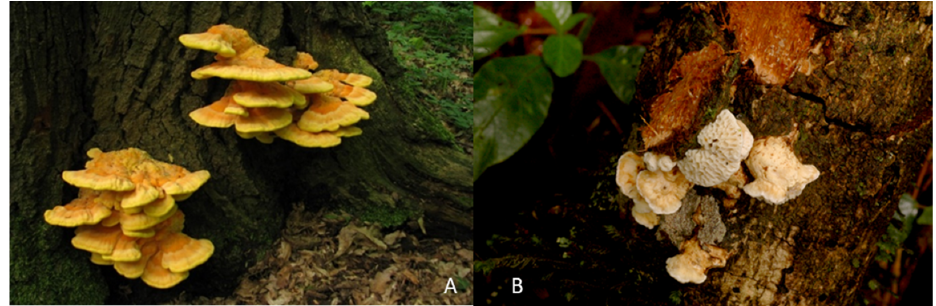
Figure 6. Fungal species studied in the current paper. ( A ) Laetiporus sulphureus. ( B ) Antrodia sp.